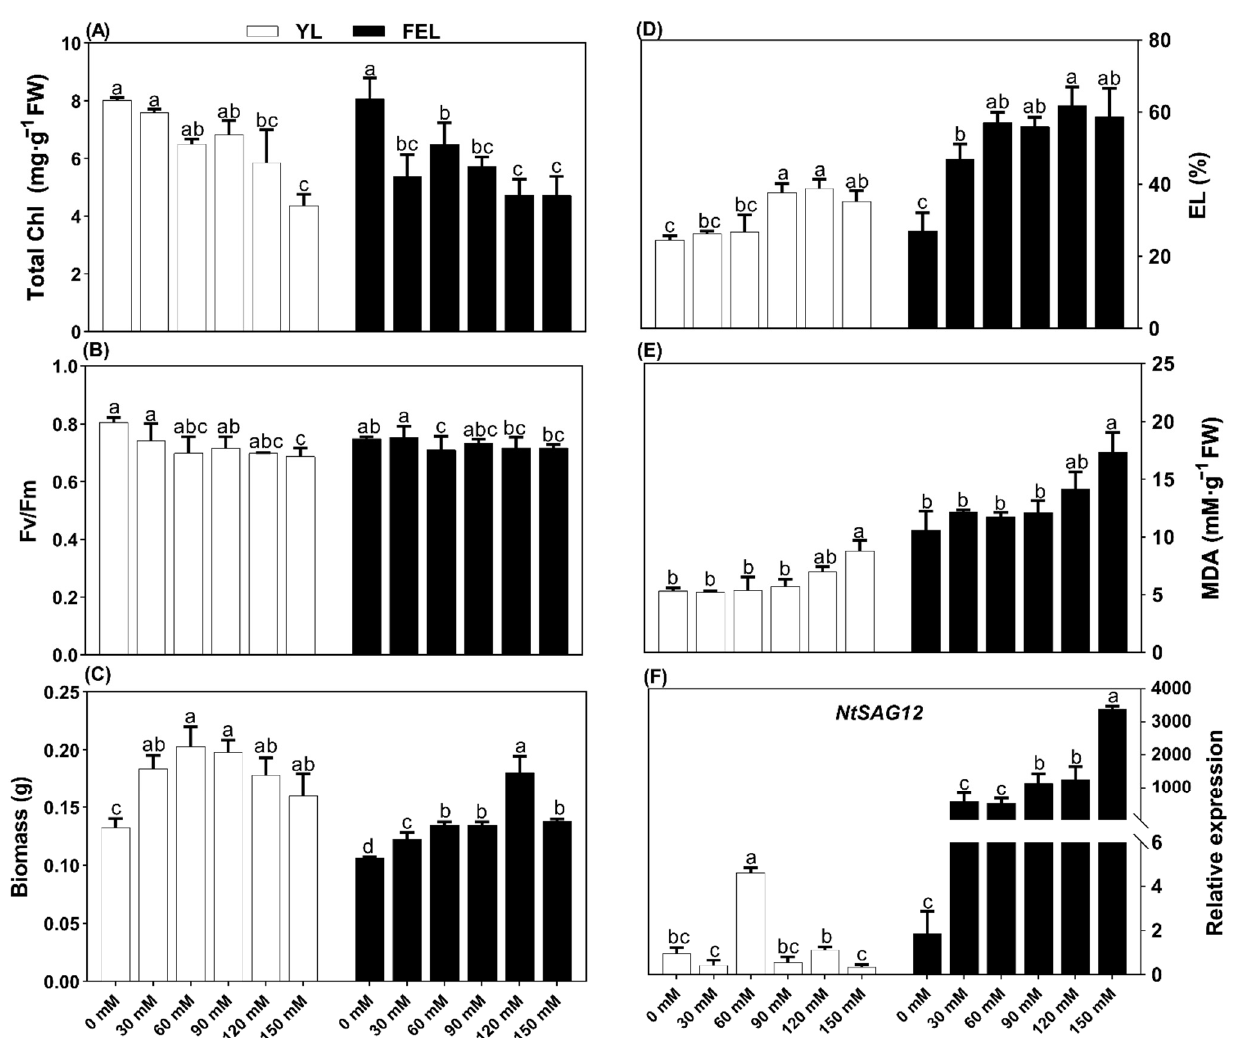
Figure 1. Characteristics of detached N. tabacum leaf discs in liquid culture with added sucrose (Suc): ( A ) total chlorophyll (Chl) content; ( B ) maximum photosynthetic efficiency (F v /F m ); ( C ) biomass; ( D ) percent electrolyte leakage (EL); ( E ) malondialdehyde (MDA); ( F ) relative expression of NtSAG12 . Lowercase letters above each bar represent statistically significant differences between treatments groups at p ≤ 0.05. Error bars indicate standard deviation of three replicates.